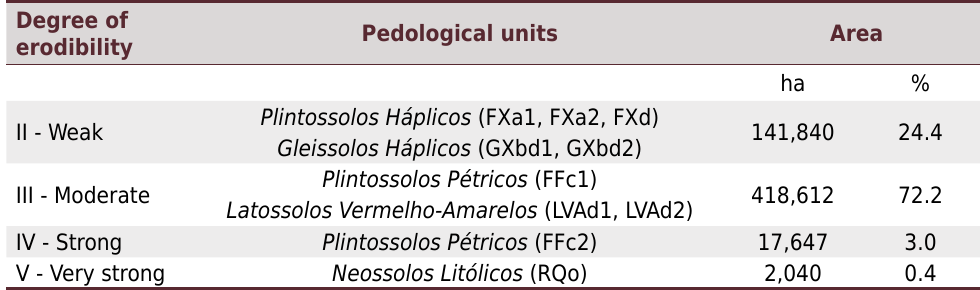
Pedological units